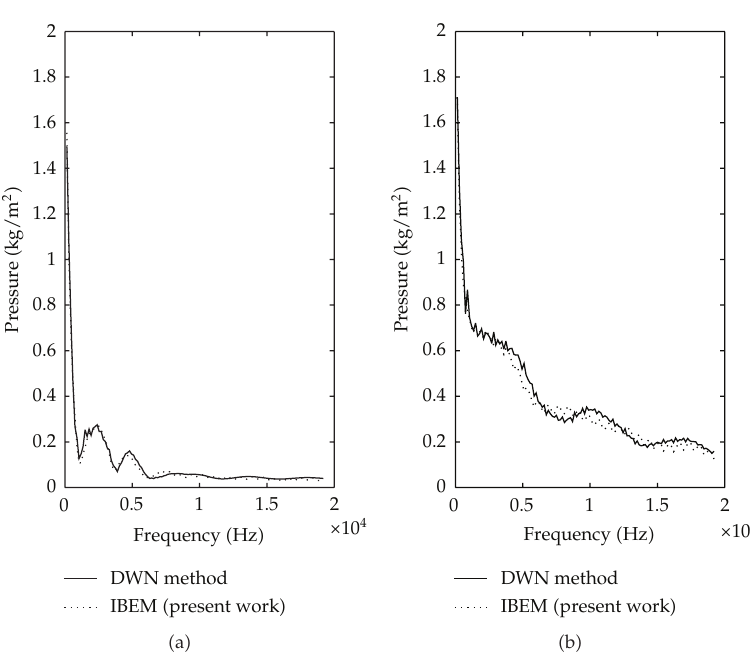
Figure 7: Spectra of pressures for water-sandstone (cid:2) left (cid:5) and water-limestone (cid:2) right (cid:5) interfaces. Results obtained by IBEM are plotted using dotted lines, while those obtained by means of DWN are drawn with continuous lines. Good agreement between IBEM and DWN is